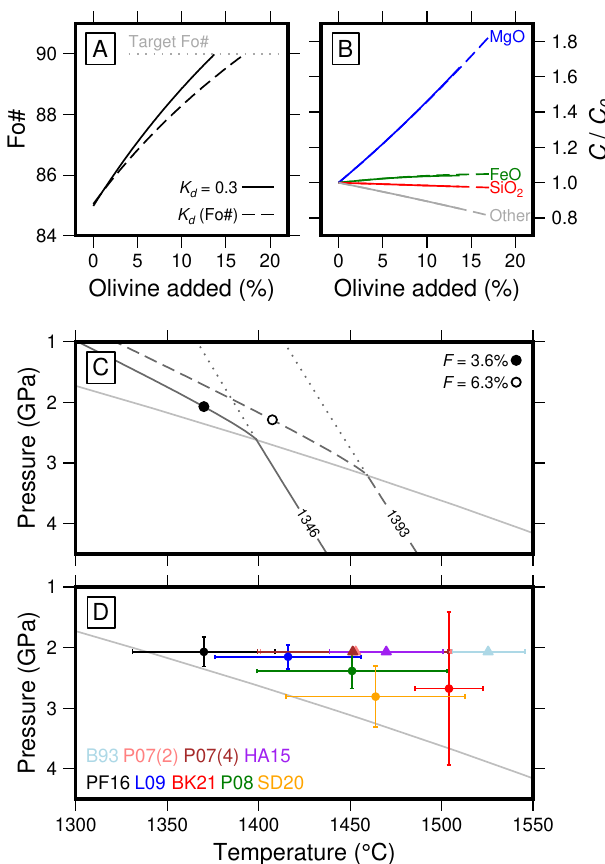
Figure 1: Worked example for Sample UT09DV04 [Plank and Forsyth 2016]. [A] Fo# of olivine in equilibrium with the melt as a function of olivine addition to Fo# = 90. Solid/dashed lines = correction pathways assuming a constant/variable olivine- melt partition coefficient ( K ). [B] Major-element oxide con- d centrations, C , normalised by their initial concentrations, C , 0 as a function of olivine addition. Solid/dashed lines = con- stant/variable K . [C] Filled/open circles = thermobarometric d [Plank and Forsyth estimate assuming constant/variable K d 2016]. Gray line = anhydrous solidus; solid/dashed lines = best-fitting melting pathways for constant/variable K cases, d labelled with corresponding T p ; dotted lines = adiabatic decom- pression pathways corresponding to melting pathways [Katz et al. 2003]. [D] Results from different schemes currently implemented in meltPT . Backtracking carried out assuming K = 0.3. Circles = thermobarometric results; triangles = ther- d mometric results, assuming pressure from Plank and Forsyth [2016]. Colour-coded according to scheme, as shown in bot- tom left. PF16 = Plank and Forsyth [2016]; L09 = Lee et al. [2009]; BK21 = Brown Krein et al. [2021]; P08 = Putirka [2008a]; SD20 = Sun and Dasgupta [2020]; B93 = Beattie [1993]; P07(2) and P07(4) = Putirka et al. [2007], Equations (2) and (4), respec- tively; HA15 = Herzberg and Asimow